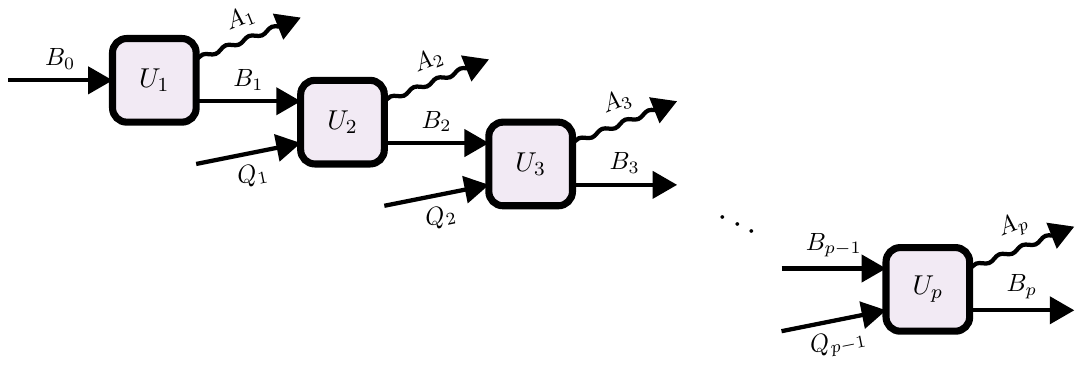
Figure 5 . The general case involves a nested series of unitary averages and Hilbert space factors as